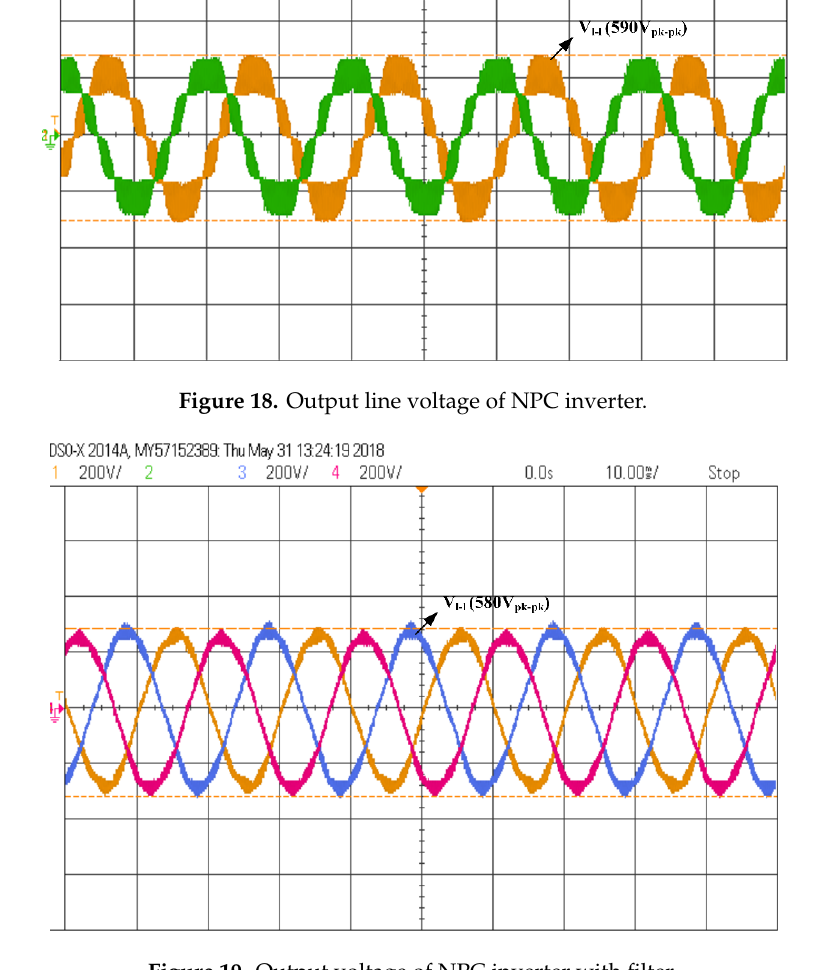
Figure 19. Output voltage of NPC inverter with filter.